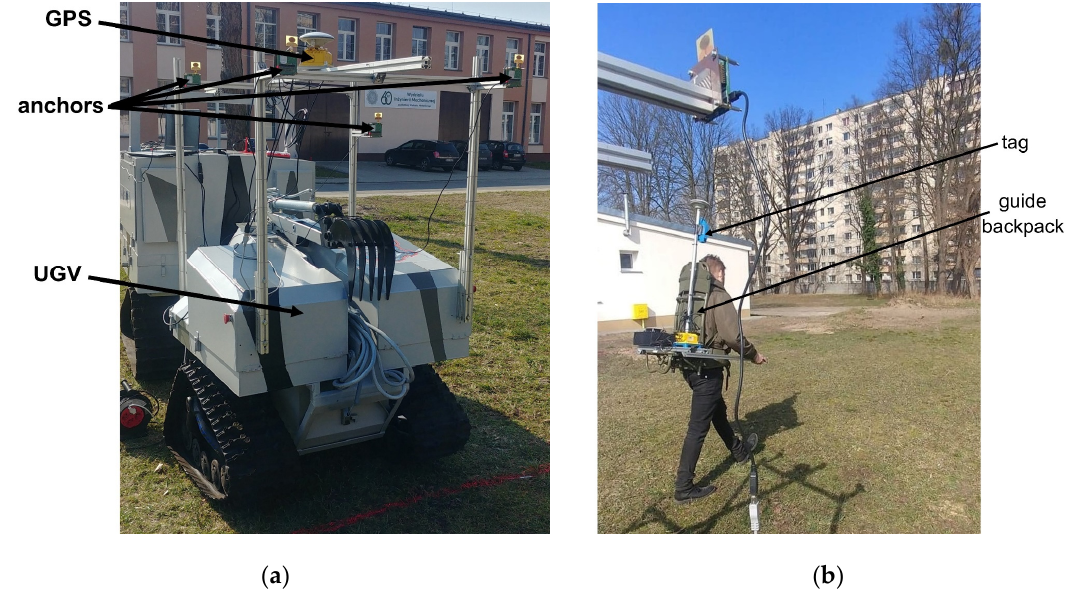
Figure 3. ( a ) Configuration of anchors on an unmanned ground vehicle (UGV), ( b ) moving guide.